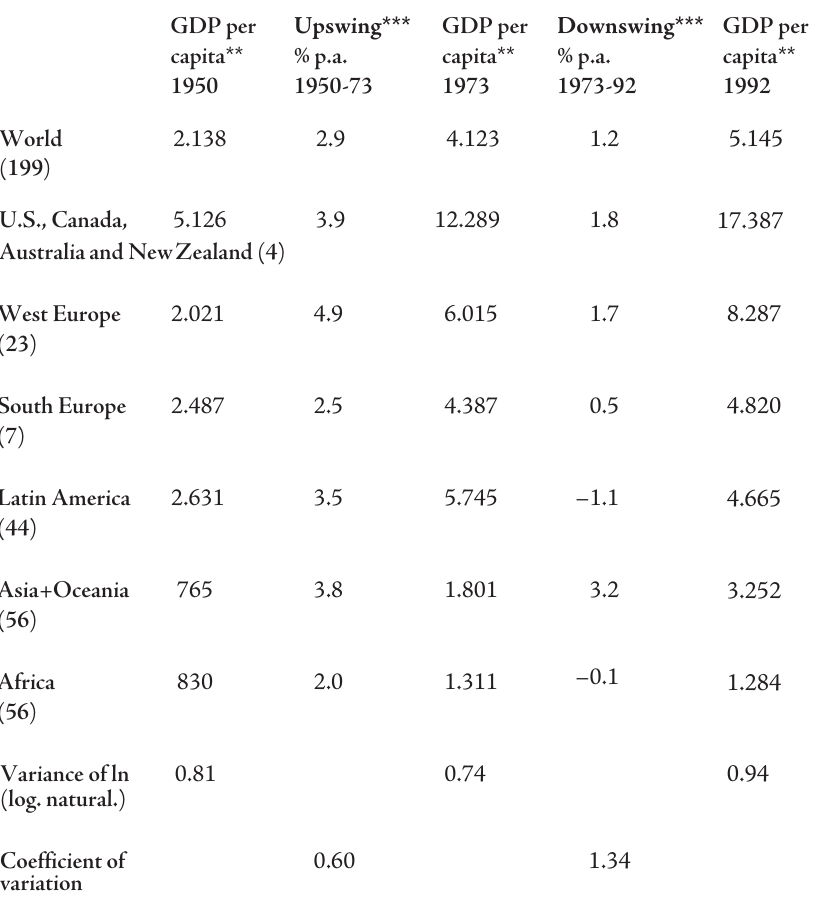
Table A1 – The development of per capita income in two growth periods after